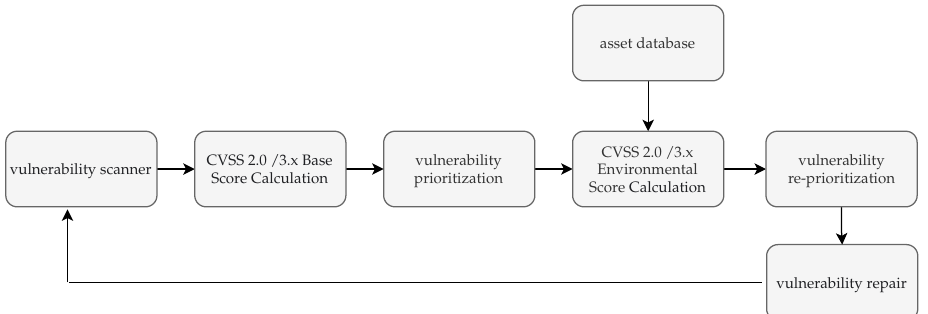
Figure 2. Model of the flow of information in the vulnerability management process with the CVSS 2.0 environmental score.